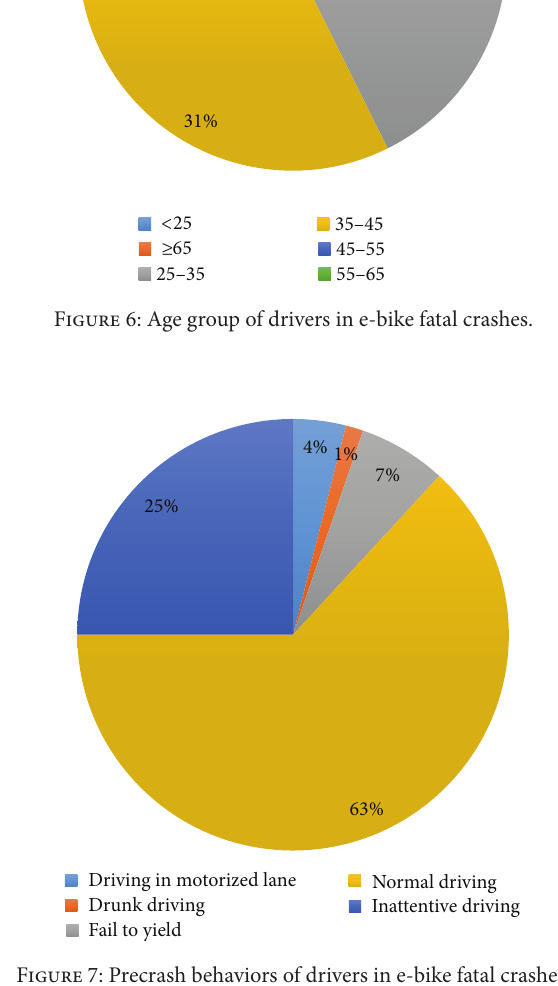
Figure 7: Precrash behaviors of drivers in e-bike fatal